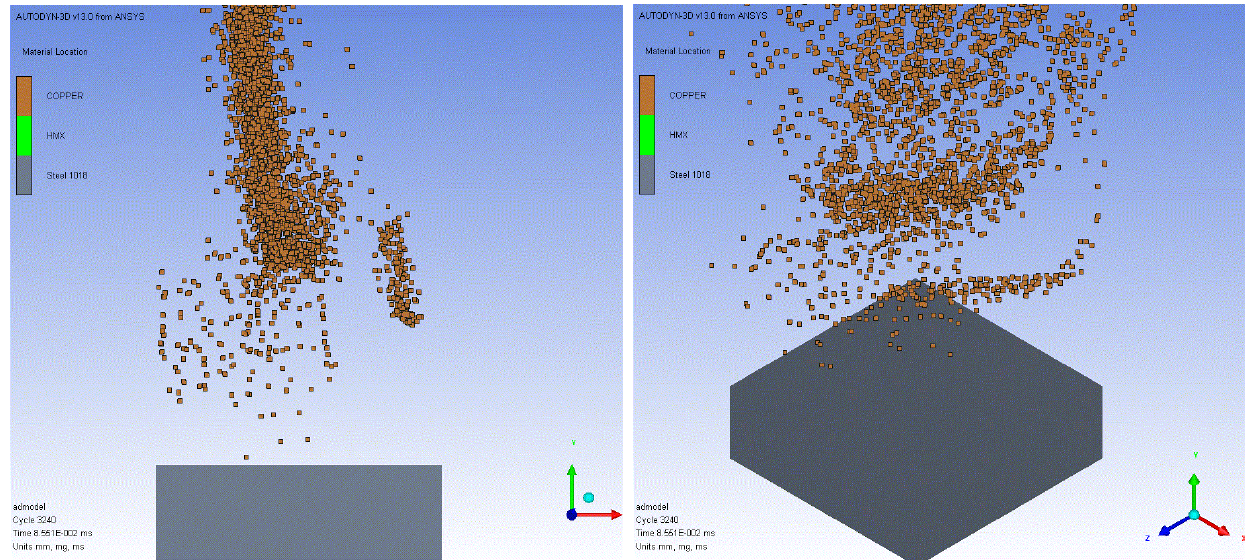
Figure 7. Front and isometric view after jet traveling 12 inches (30.48 cm).